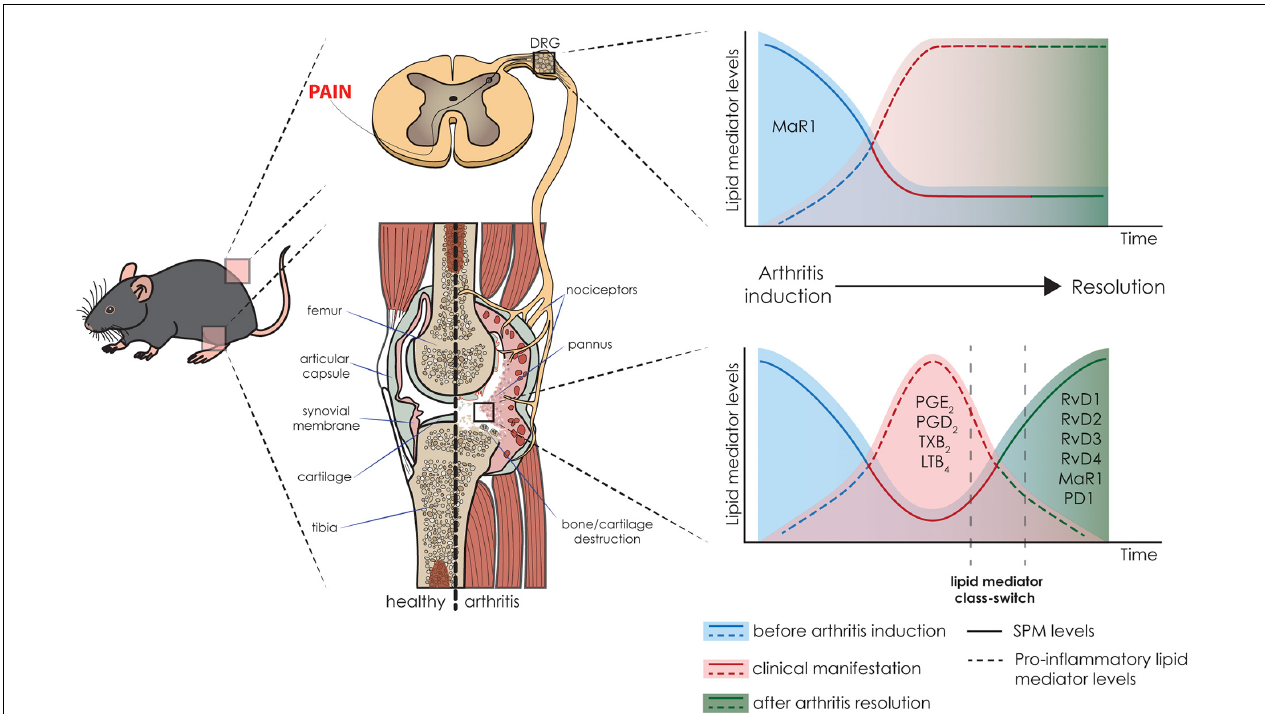
FIGURE 2 | Pre-clinical levels of lipid mediators and their correlation with arthritis status. Schematic representation of the fluctuation in the levels of lipid mediators, i.e., pro-inflammatory lipid mediators and SPMs, in arthritis initiation, resolution, and associated pain in the K/BxN-induced arthritis model. The time-dependent resolution process is singular and tissue-specific; therefore, there is a variation in the resolution between the joint and DRG. In the joint, the inflammatory events lead to an increase in pro-inflammatory lipid mediators and decrease in SPM levels. In the resolution phase, the lipid class switch supports the inflammation resolution and restore the levels of SPMs (Arnardottir et al., 2016). While the joint has the health status restored, in the DRG, the class switch does not occur at the same pace, and the imbalance between pro-inflammatory mediators and SPMs in the dorsal root ganglia (DRG) result in persistent pain (Allen et al., 2020).